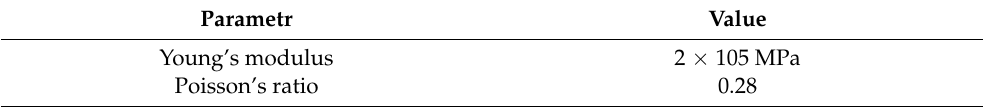
Table 3. Material